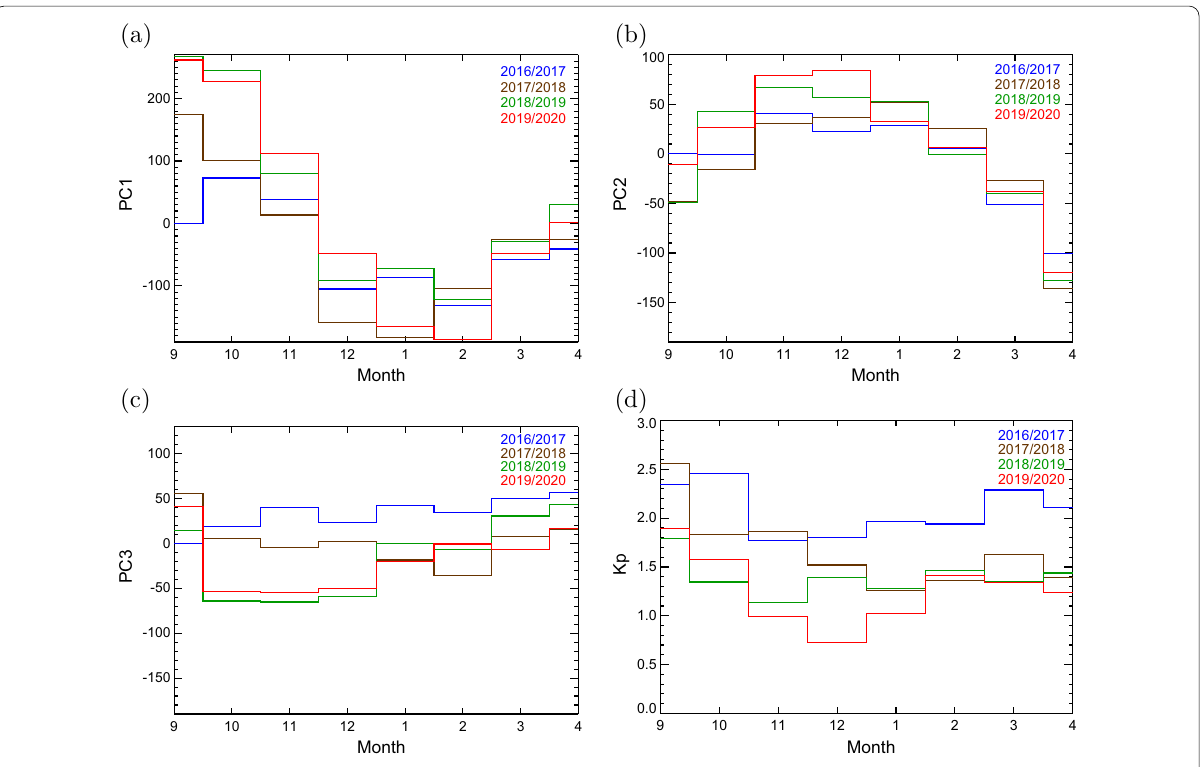
Fig. 3 Seasonal variations of the average ( a ) PC1, ( b ) PC2, ( c ) PC3 coefficients, and ( d ) Kp